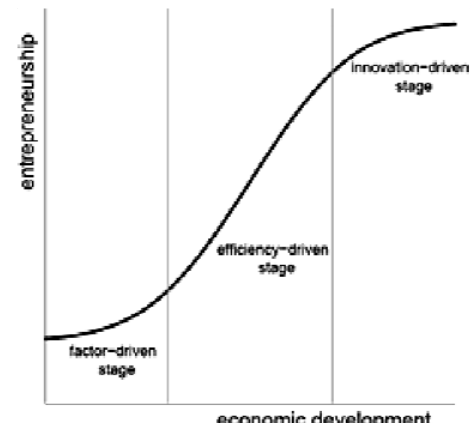
Fig. 1. Relationship between economic development and entrepreneurship Source: Porter et al. (2002) as mentioned by Zoltan J. Acs